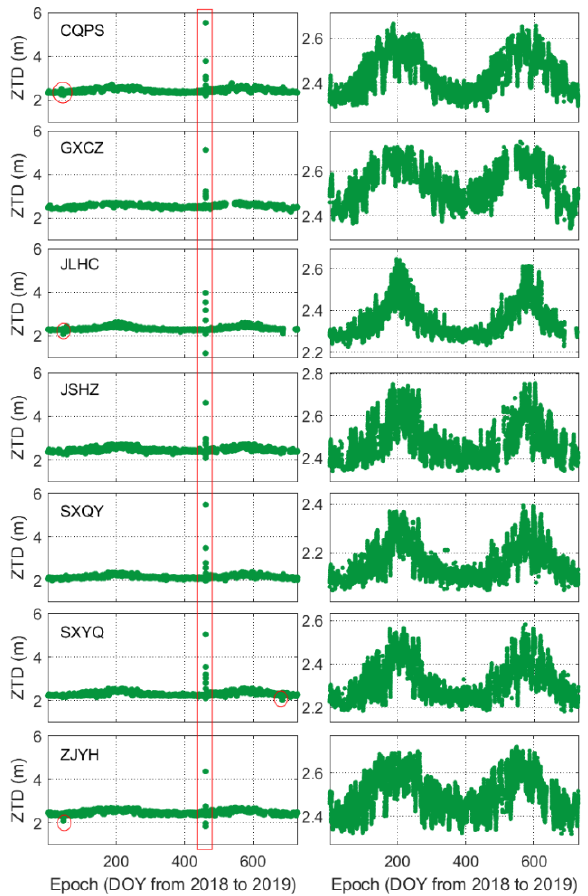
Figure 3. ZTD time series of seven GNSS stations before ( left ) and after ( right ) the outliers were eliminated. A red box marks obvious outliers in the left panel. N = 730, representing two years, collected from 1 January 2018 to 31 December 2019.